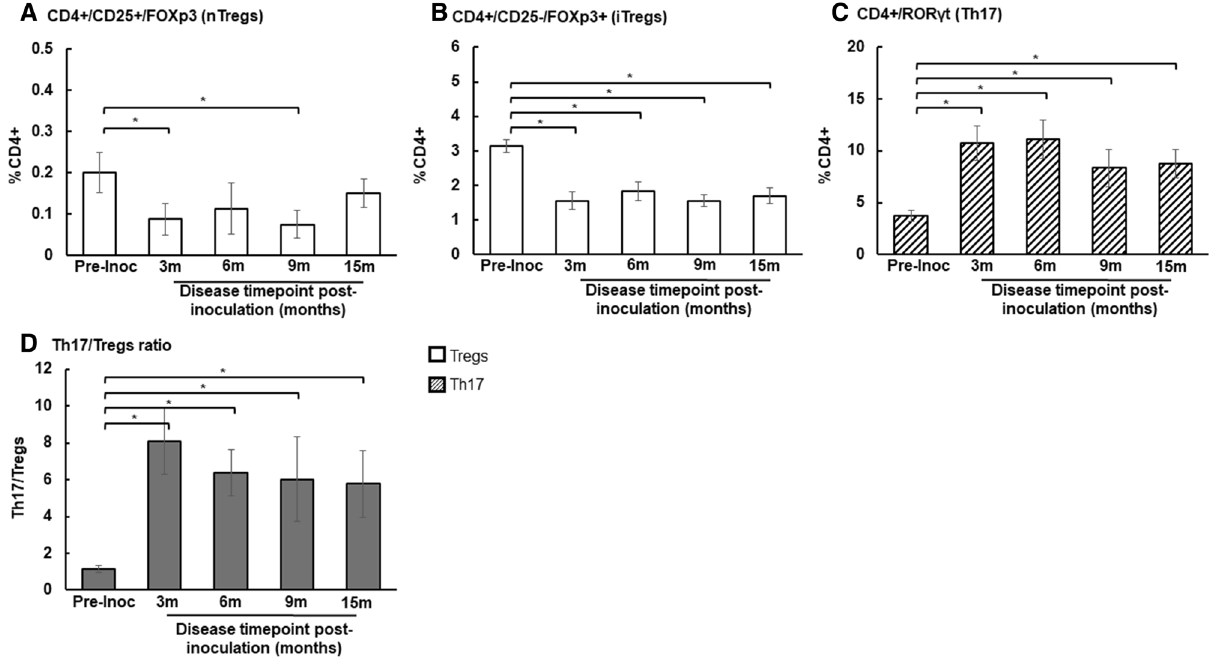
Figure 1. Immune cell population in peripheral blood samples of non-human primates. ( A–C ) Peripheral Treg and Th17 cell populations were measured for 8 baboons at pre-inoculation and post-inoculations: 3, 6, 9 and 15 months. ( A ) Natural Tregs (nTregs); ( B ) Inducible Tregs (iTregs); ( C ) Th17 population. ( D ) Th17/Tregs ratio. *Indicates significance between groups. Mann–Whitney U -test, p -value <